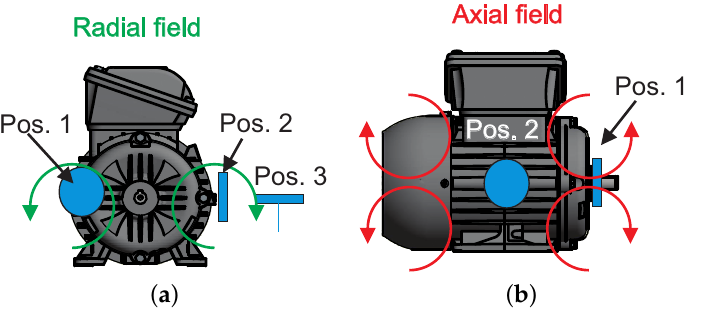
Figure 2. Magnetic stray flux components: ( a ) Radial stray flux. ( b ) Axial stray